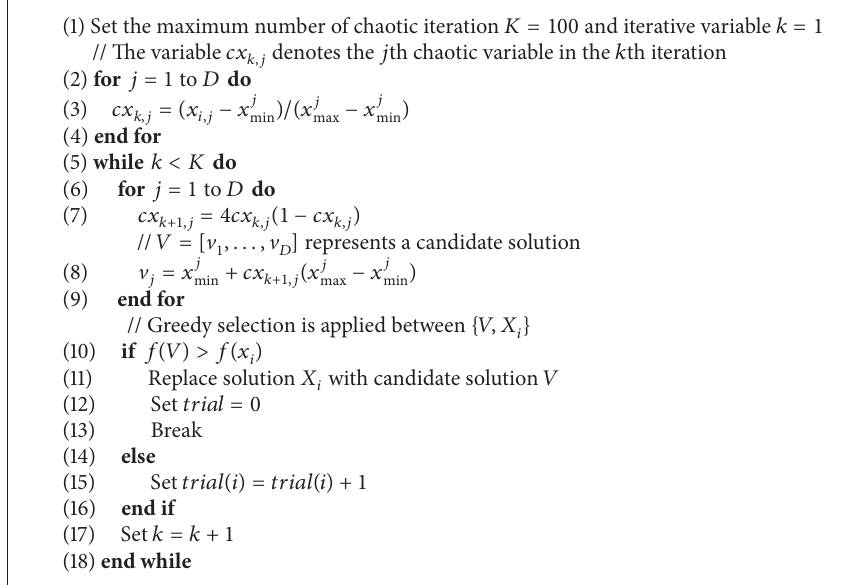
Algorithm 3: Chaotic search for scout bees.